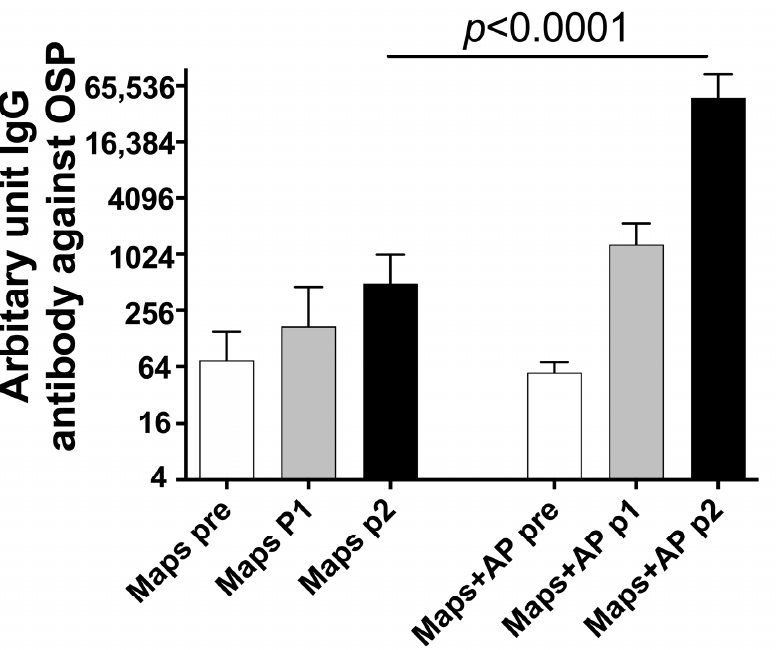
Figure 3. The effect of alum phosphate adjuvant on OSP antibody generation. Rabbits were immu- nized with CP1-OSP MAPS. Each group contained ten rabbits. Bars showed geometric mean antibody titers and 95% confidence intervals.